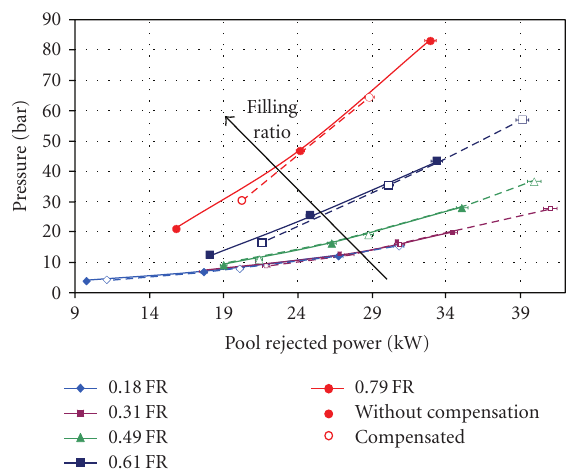
Figure 3: E ff ects of filling ratio and pool condenser rejected power on system pressure (both with and without heat losses compensation)